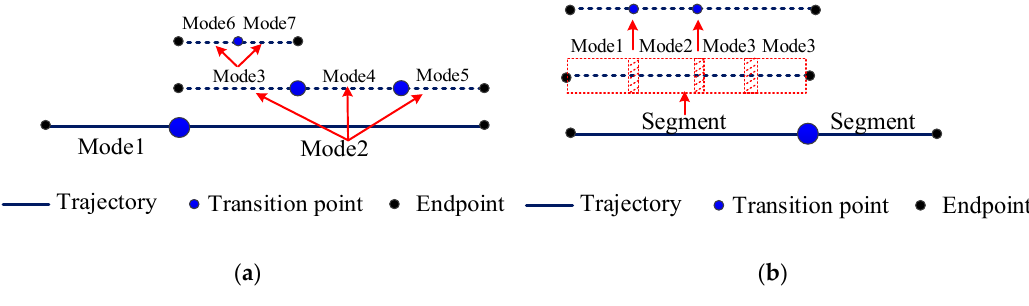
Figure 6. Transition point recognition of MMT. ( a ) Direct partitioning mode; ( b ) indirect partitioning